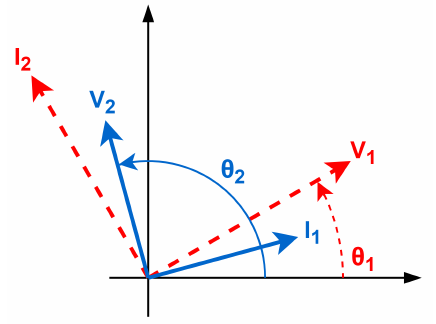
Figure 6. Phasor diagram of variables V 1 , V 2 , I 1 and I 2 .